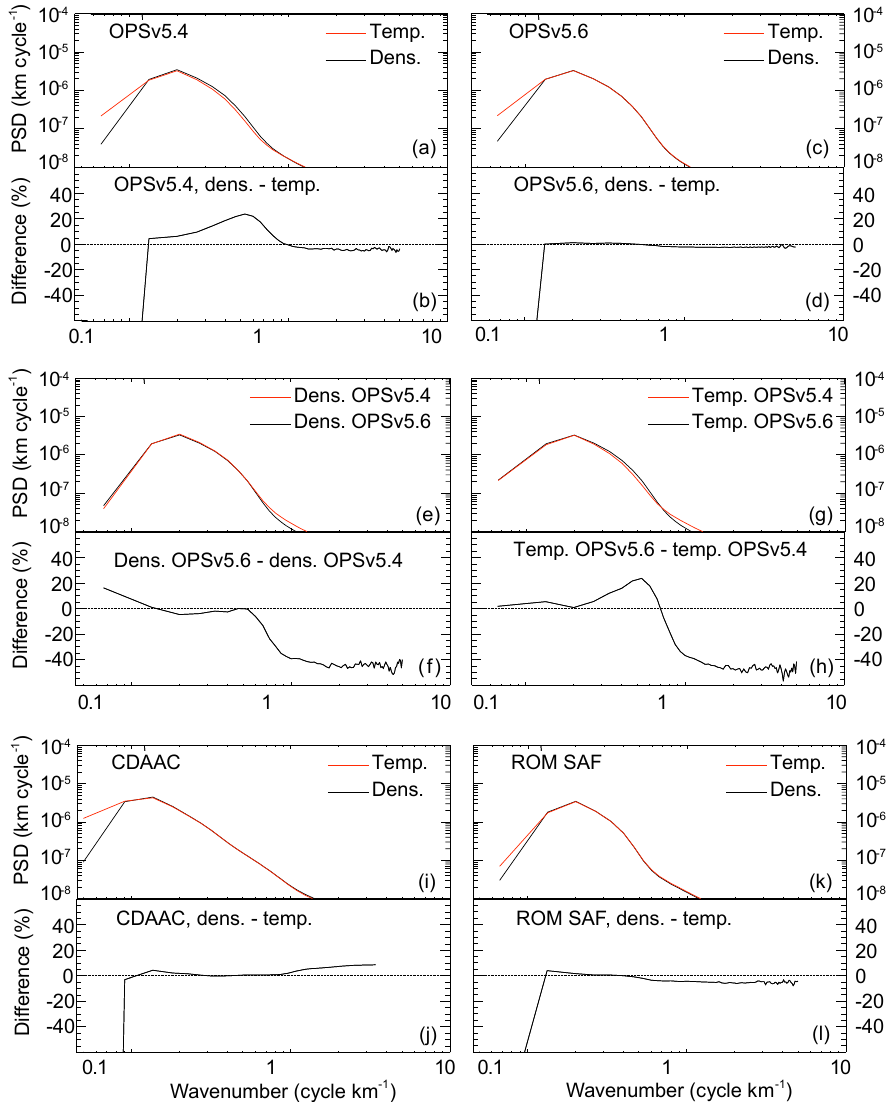
Figure 2. Power spectra density (PSD) of normalized perturbations and their differences for selected variables and datasets (indicated in the individual